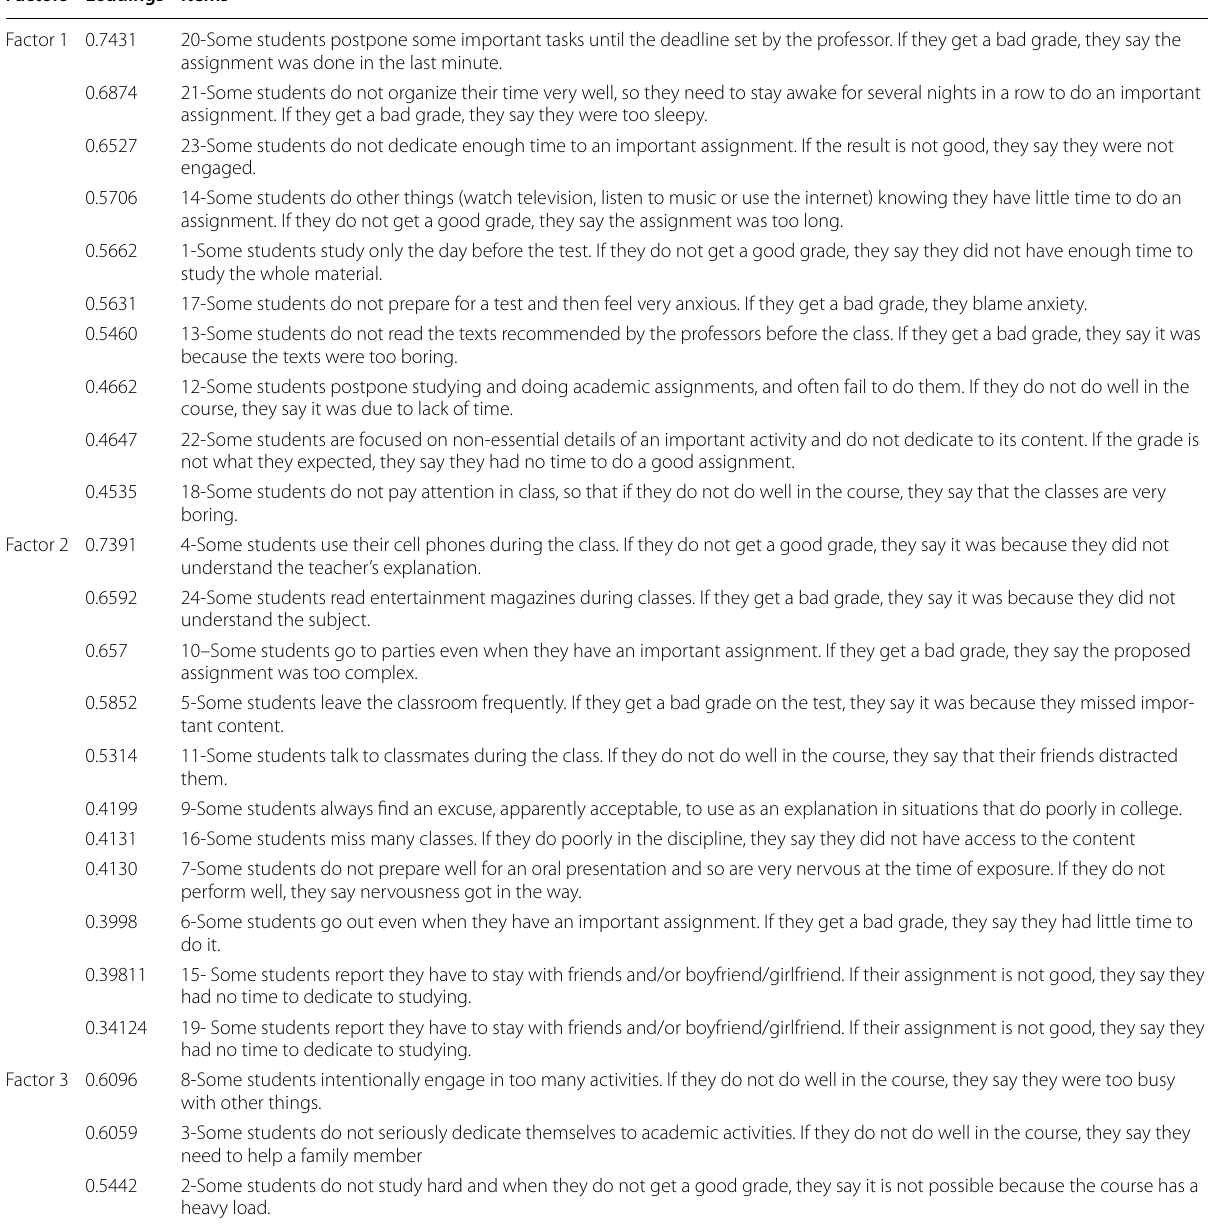
Table 3 Factor composition and items loading after varimax orthogonal